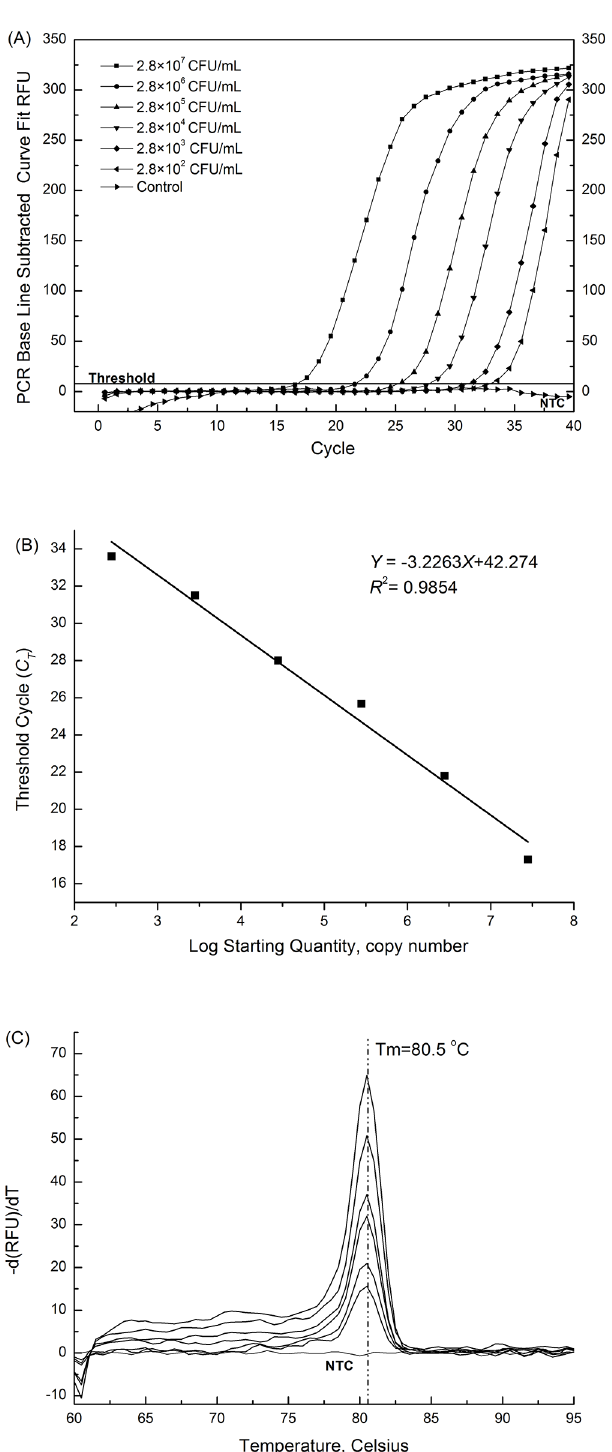
Fig 2. Sensitivity of the real-time PCR detection of Alicyclobacillus spp.. (A) Real-time PCR amplification of the target gene fragment with different concentratioans. NTC: no template control; (B) Standard curve generated from the data plotted in panel; (C) Melt peaks of real-time PCR products of 10-fold serial dilutions of Alicyclobacillus spp.